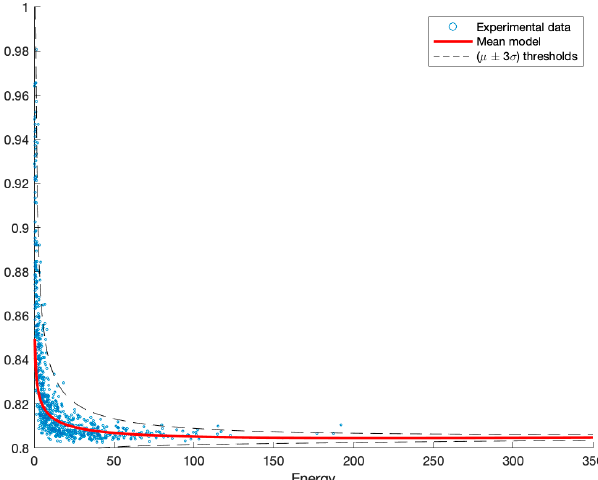
Figure 9. Entropy-energy dispersion for a building complex near San Giovanni station in the period from 2017 to 2019.